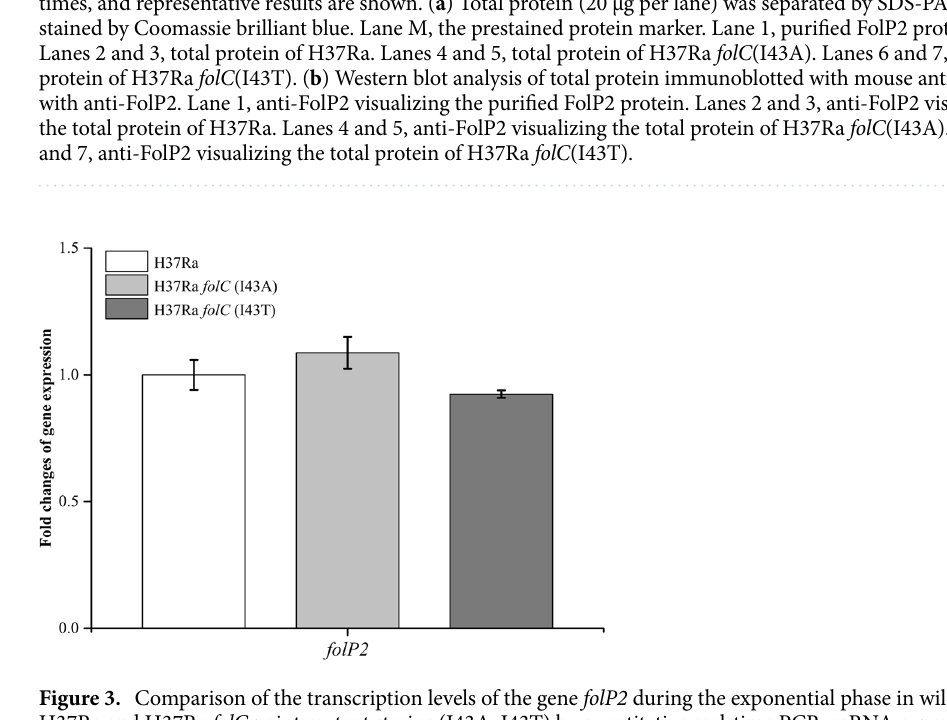
FolC mutations did not affect the expression of folP2 . Results of the quantitative real-time PCR assay showed that no difference in the folP2 expression level could be observed between M. tuberculosis H37Ra and the two folC mutants, which was confirmed by subsequent western blot analysis (Figs. 2 and 3). To deter- mine production levels of p ABA in the three different H37Ra strains, an Escherichia coli ( E. coli ) W3110 Δ pabB mutant was used as previously described 29 . When E. coli W3110 Δ pabB was cultured in E minimal medium plus culture filtrates from different H37Ra strains, there was obviously less growth when culture filtrates from the two folC mutants were used (Fig. 4), suggesting a decreased production of p ABA.